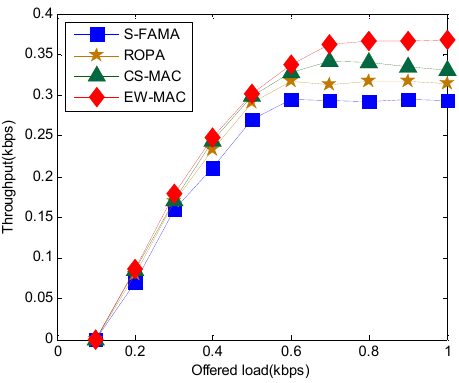
Figure 6. Throughput at different offer loads.